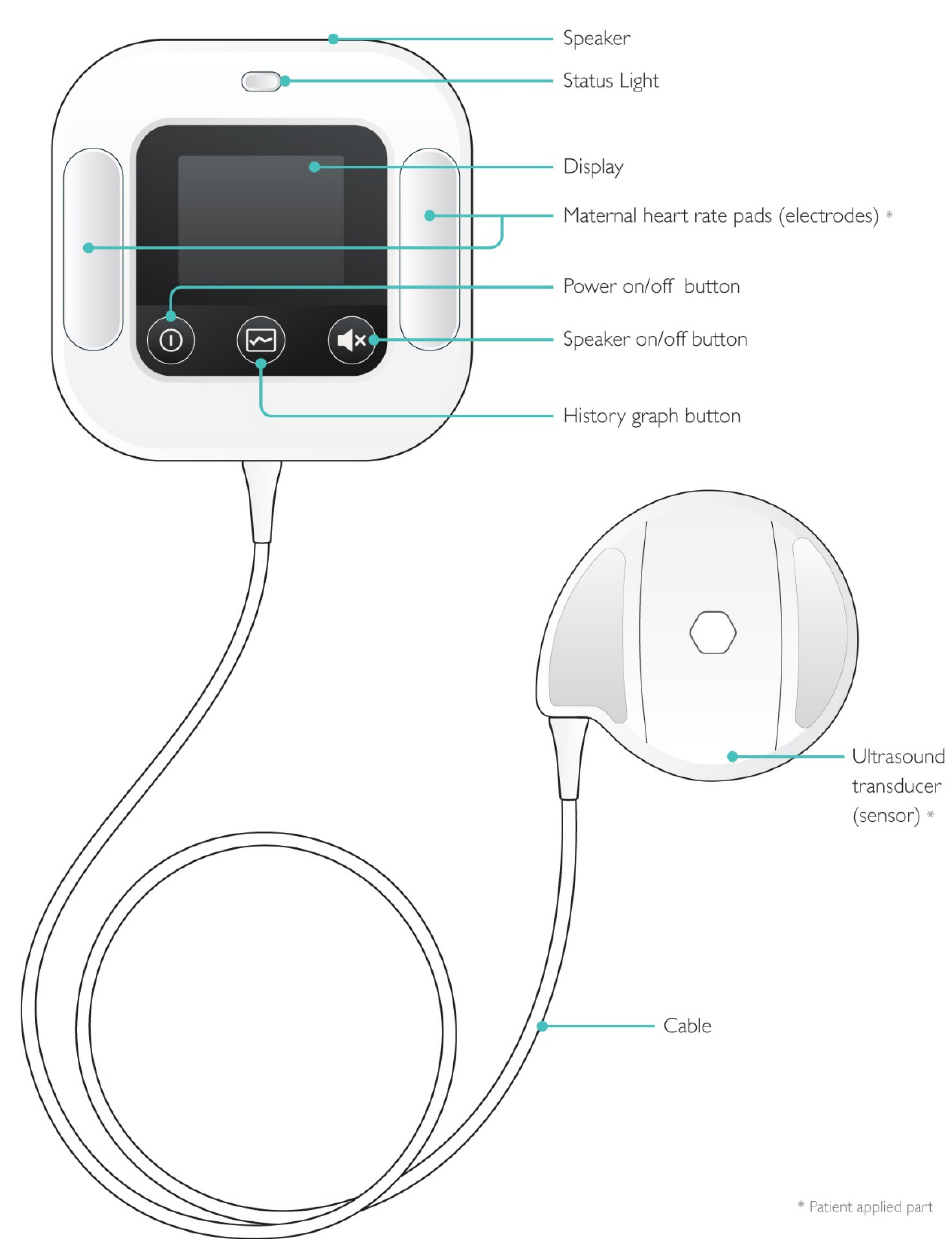
Figure 1. Moyo—the novel continuous FHR (foetal heart rate) monitor (Laerdal Global Health). * patient applied part.